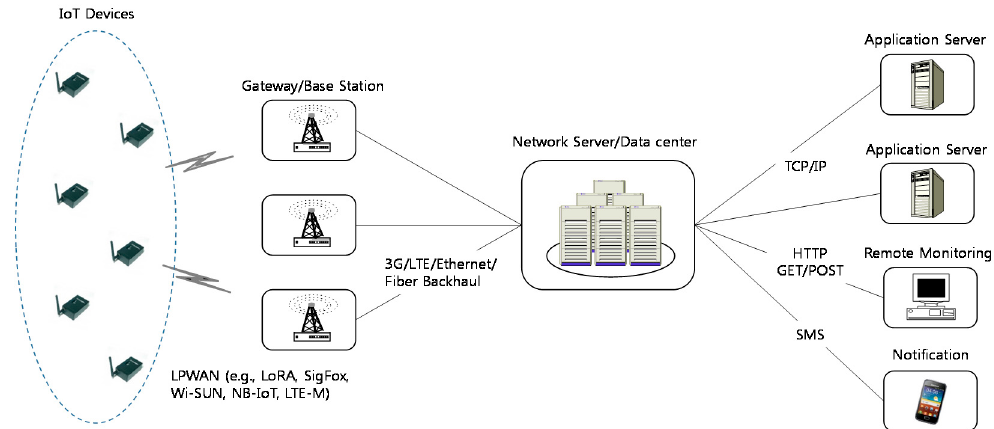
Figure 1. Low power wide area network (LPWAN) end-to-end network architecture for Internet of Things.